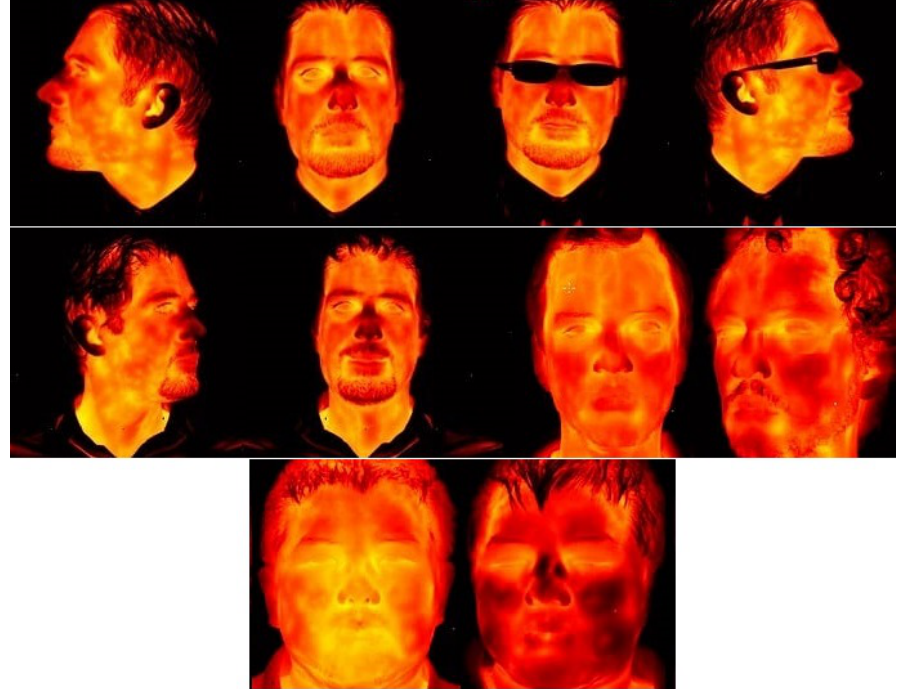
Figure 3. A sample of UL-FMTV after a time lapse with different head orientations, glasses and temperature exposure